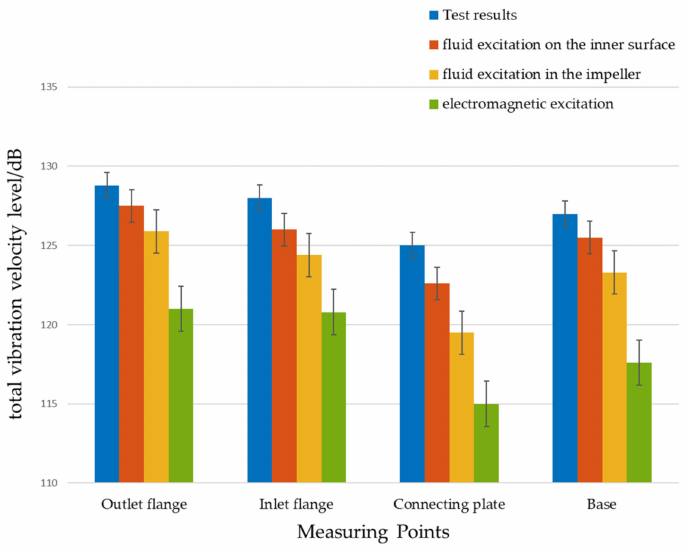
Figure 19. The total vibration velocity level caused by different excitation sources at each measuring point. Table 4. The value of total vibration velocity level of different measuring points obtained by simula- tion and